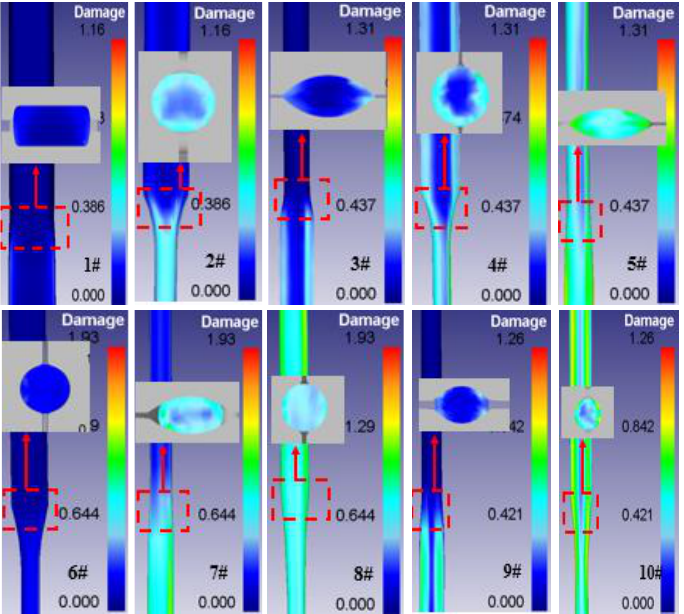
Figure 9. Damage program of hot continuous rolling copper rod and rolling section.